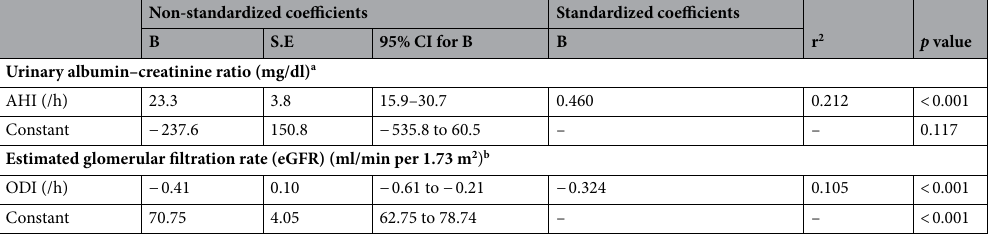
Table 4. Independent predictors of urinary albumin–creatinine ratio and estimated glomerular filtration rate in the multivariate linear regression analyses. AHI apnea–hypopnea index, ODI desaturation index, BMI body mass index, FMI fat mass index, SBP systolic blood pressure, DBP diastolic blood pressure, HbA1c glycated hemoglobin, HDLc high-density lipoprotein cholesterol, LDLc low-density lipoprotein cholesterol, eGFR estimated glomerular filtration rate, ACEi angiotensin-converting enzyme inhibitors, ARB angiotensin II receptor blockers, MRA aldosterone receptor antagonists, tSaO 2 < 90% percentage of recording time with oxygen saturation < 90%, SaO 2 oxygen saturation. a Adjusted for age, sex, BMI, FMI, duration of diabetes, smoking habit, SBP, DBP, HbA1c, cholesterol, HDLc, LDLc, triglycerides, eGFR, treatment with insulin, ACEi, ARB or MRA drugs, desaturation index, tSaO 2 < 90%, mean nocturnal SaO 2 and lowest nocturnal SaO 2 . b Adjusted for age, sex, BMI, FMI, duration of diabetes, smoking habit, SBP, DBP, HbA1c, cholesterol, HDLc, LDLc, triglycerides, treatment with insulin, ACEi, ARB or MRA drugs, AHI, tSaO 2 < 90%, mean nocturnal SaO 2 and lowest nocturnal SaO 2 .